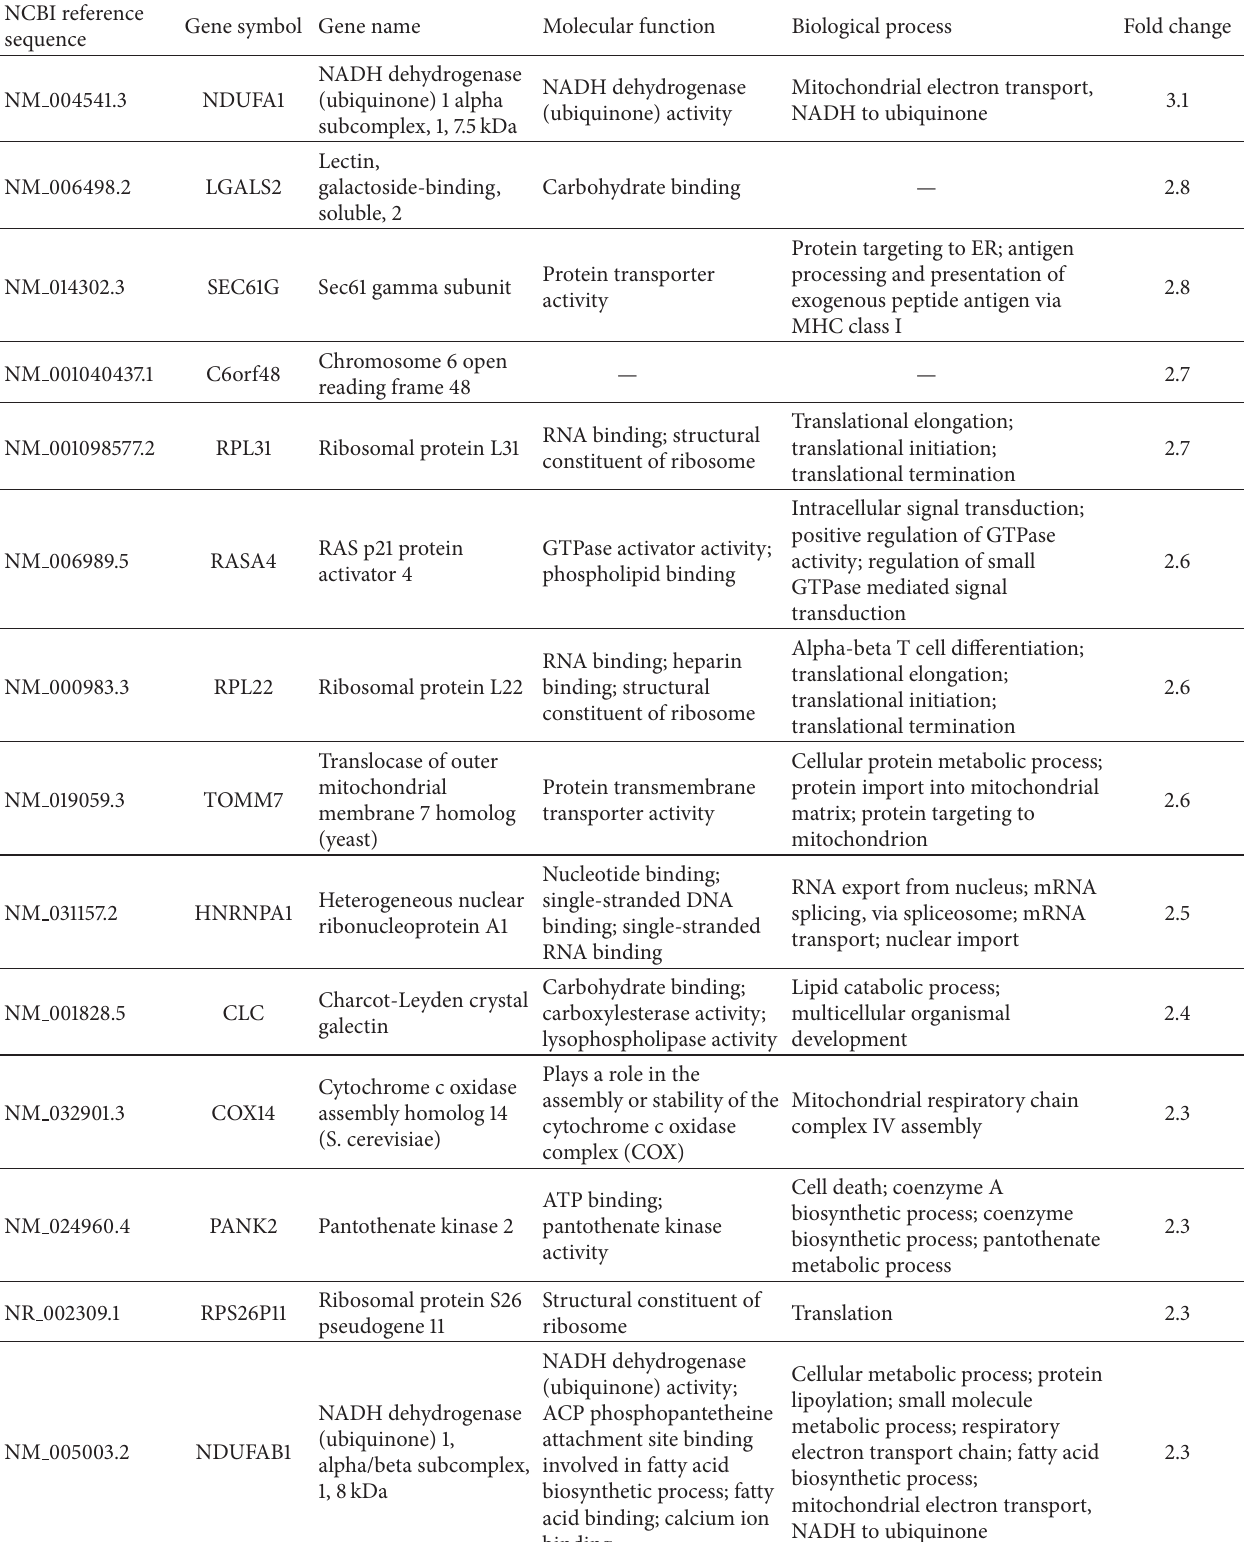
Table 2: Genes upregulated in RTT patients by LIMMA and SAM